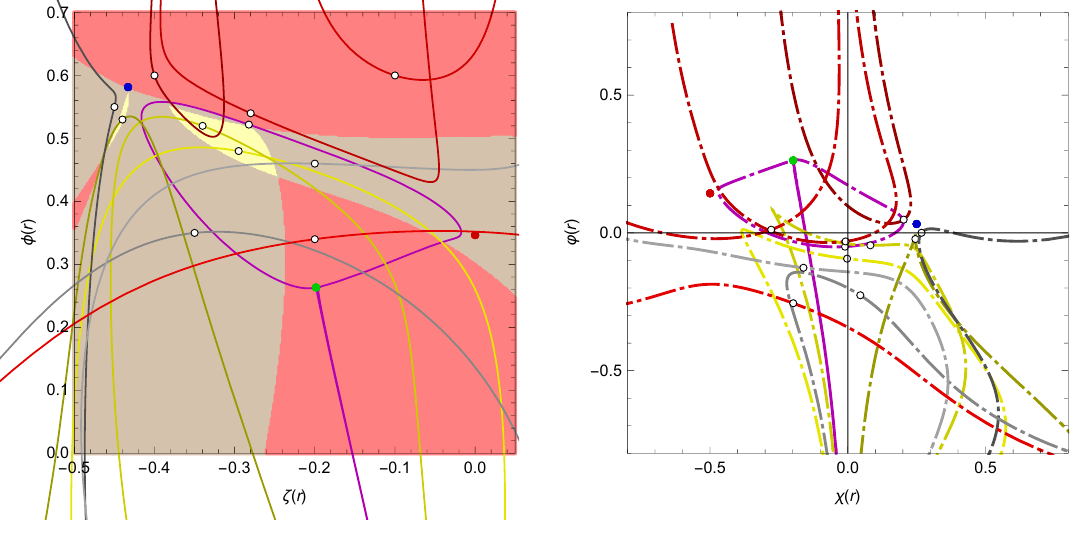
Figure 16. Space of N = 1 Janus solutions with SU(3) symmetry that approach U(3) and SU(3) critical